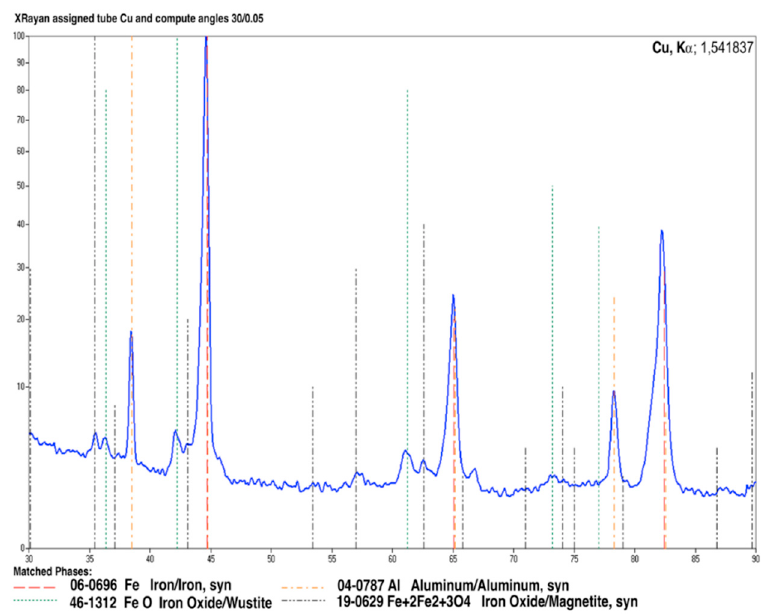
Figure 6. X-ray diffraction (XRD) diffraction pattern of the arc sprayed Fe-Al coating.